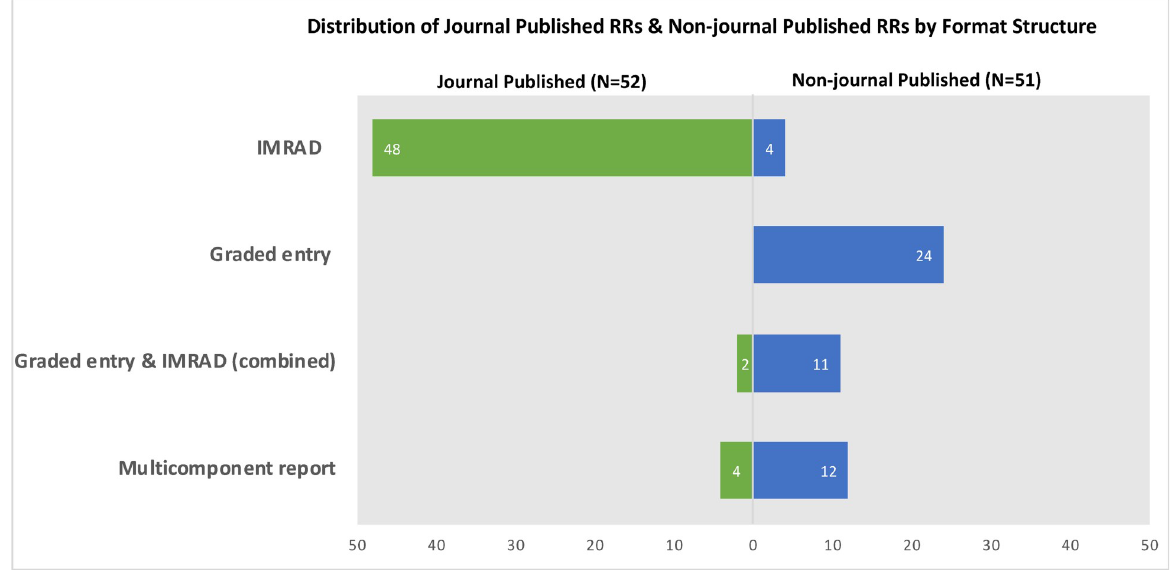
Fig 2. Rapid review format structures identified. Breakdown and comparison of the types of different rapid review report format structures identified across the journal published and non-journal published groups.